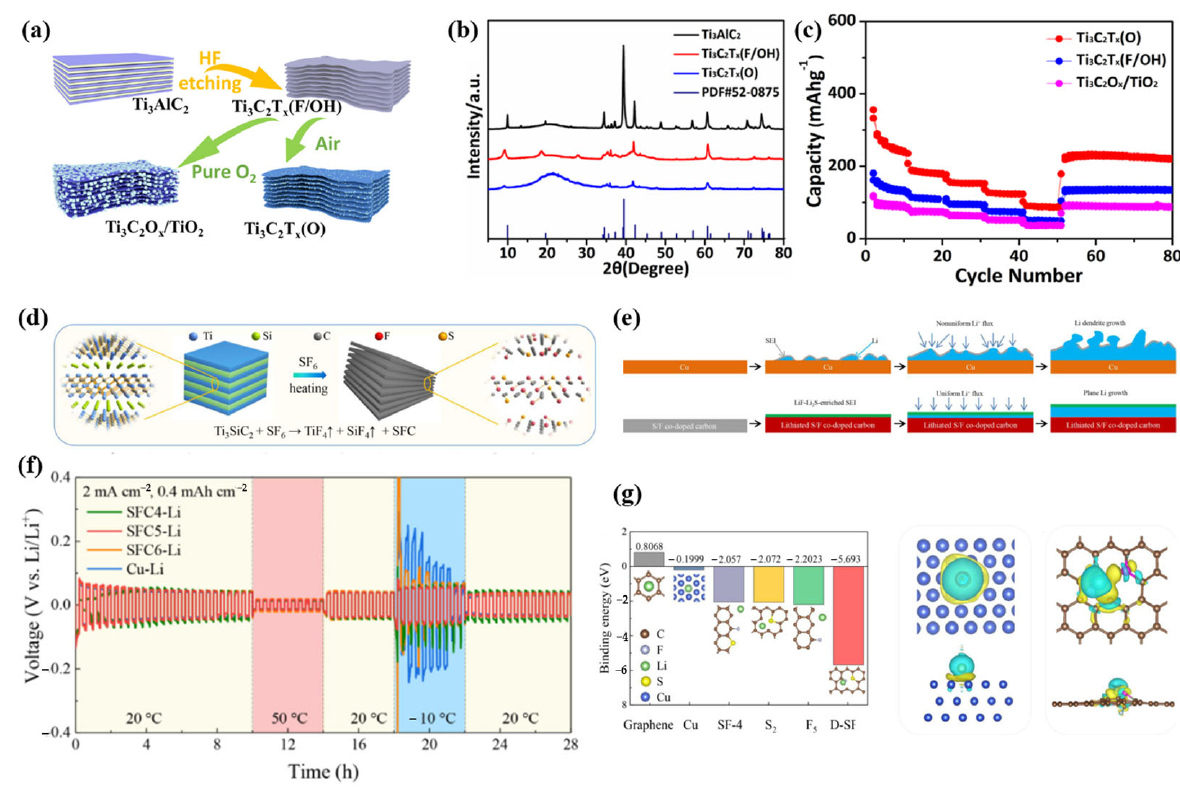
Figure 5. ( a ): Schematic illustration of the fabrication process of pristine MXene Ti 3 C 2 T x (F/OH), more O functional group substitutions for F in MXene-Ti 3 C 2 T x (O) and Ti 3 C 2 O x /TiO 2 . ( b ): XRD patterns of the different samples. ( c ): Rate performances of various materials. ( a – c ) Reproduced with permission from [87]. ( d ): Schematic illustration of the synthetic process of the SFC. ( e ): The schematic illustration of the electrochemical lithiation process of Li on a Cu anode or SFC. ( f ): Cycling stability of symmetric cells that incorporated the different electrodes; the temperature was switched repeatedly every 20 cycles between − 10 ◦ C and 50 ◦ C. ( g ): Summary of calculated binding energies of Li with Cu, pure graphene, and different doping sites on SFC5. The top view and the side view of the charge density differences of Cu, and d-SF-1 site with one Li atom adsorbed. The lithium, copper, carbon, sulfur, and fluorine atoms are marked as green, blue, brown, yellow, and gray, respectively. ( d – g ) Reproduced with permission from [88].